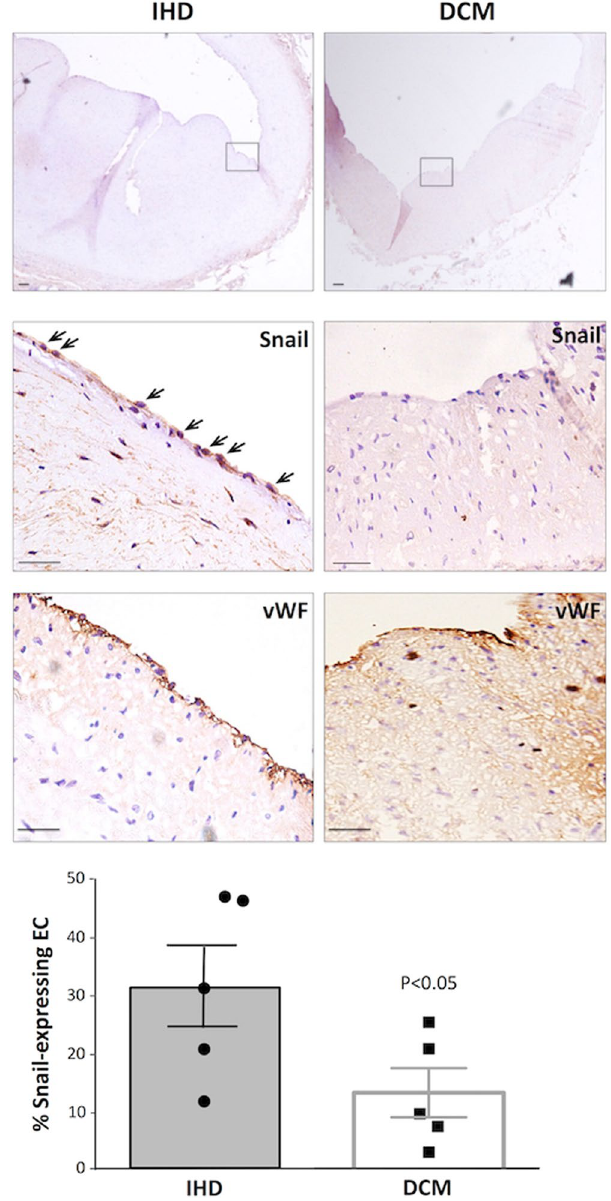
Figure 6. Expression of Snail in endothelium overlying human coronary artery plaques. The expression of Snail in coronary arteries of patients with ischemic heart disease (IHD) or dilated cardiomyopathy (DCM) was studied by immunohistochemistry using specific primary antibodies and HRP-conjugated secondary antibodies (brown). Consecutive sections were stained for EC using anti-vWF antibodies (brown). Sections were counterstained using hematoxylin. Representative images are shown. The region boxed (upper panel, 10X magification) is shown at higher magnifications (centre and lower panels, 40X). Scale bar 20 μ m. The proportion of EC that expressed Snail was calculated for each section. Data were pooled from six plaques and mean values + / − SEM are presented. Differences between means were assessed using an unpaired